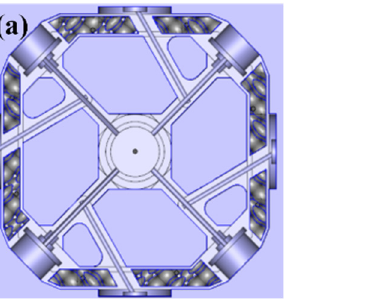
Figure 14. Schematic diagram of the lightweight assembly block: ( a ) schematic diagram based on D structure filling, ( b ) homogenization diagram of the lightweight assembly block. Table 4. Parameters and theoretical properties of unit cell.